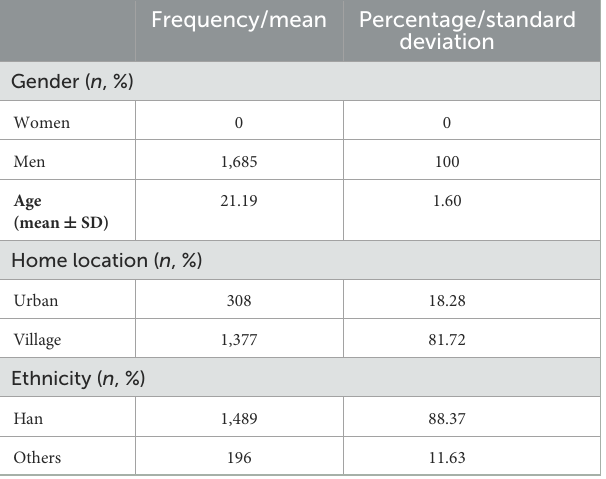
TABLE 3 Demographic information of the 1,685 participants ( n = 1,685). TABLE 4 Demographic information of the 78 participants who participated in the evaluation of the questionnaire ( n =